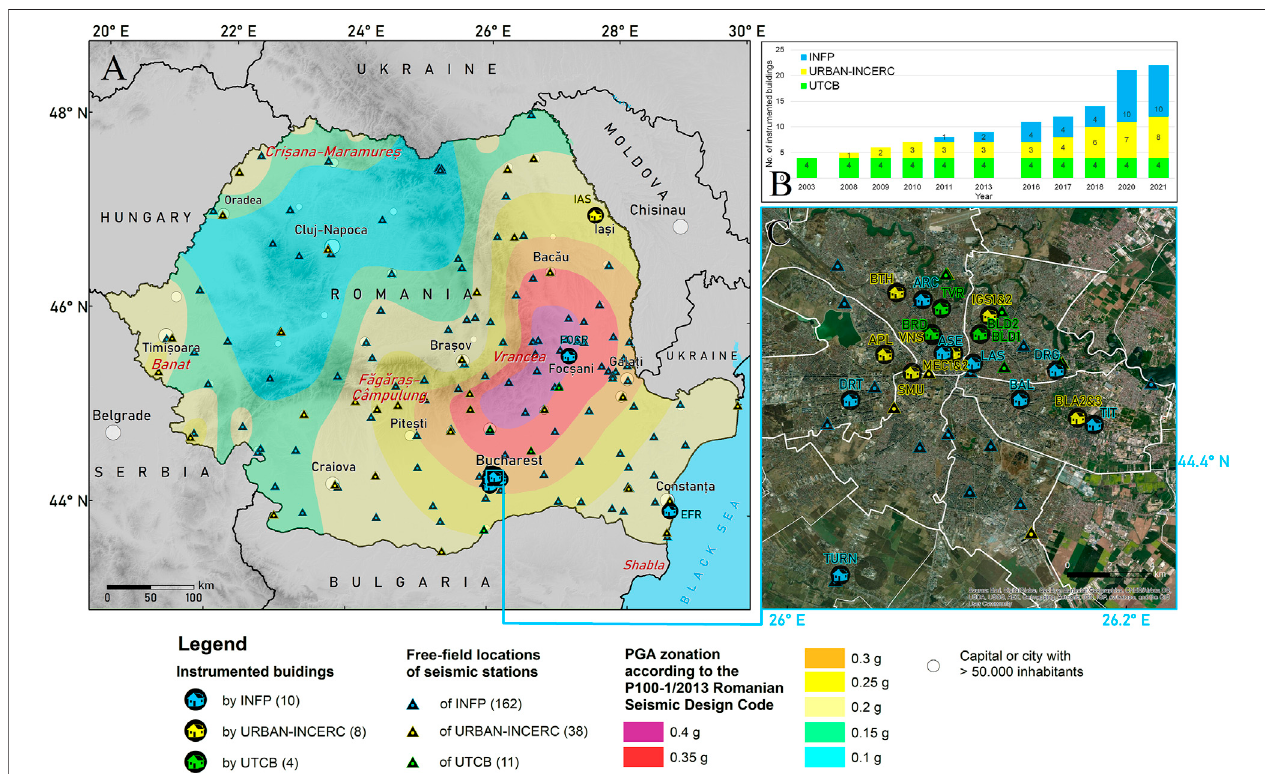
FIGURE1| Mapoftheseismicstationsinstalledinbuildings,byINFP(10buildings,36sensors),URBAN-INCERC(8buildings,20sensors)andUTCB(4buildings, 13sensors)andfree- fi eld,andtheseismiczonationfromtheRomanianseismicdesigncodeP100-1/2013,indicatingthemainseismicsources(redtext) (A) ,thetimeline oftheinstallationyearforthe22currentlyinstrumentedstructures,foreachinstitution (B) ,andadetailedmapofBucharestwiththeinstrumentedstructuresandfree- fi eld stations (C)